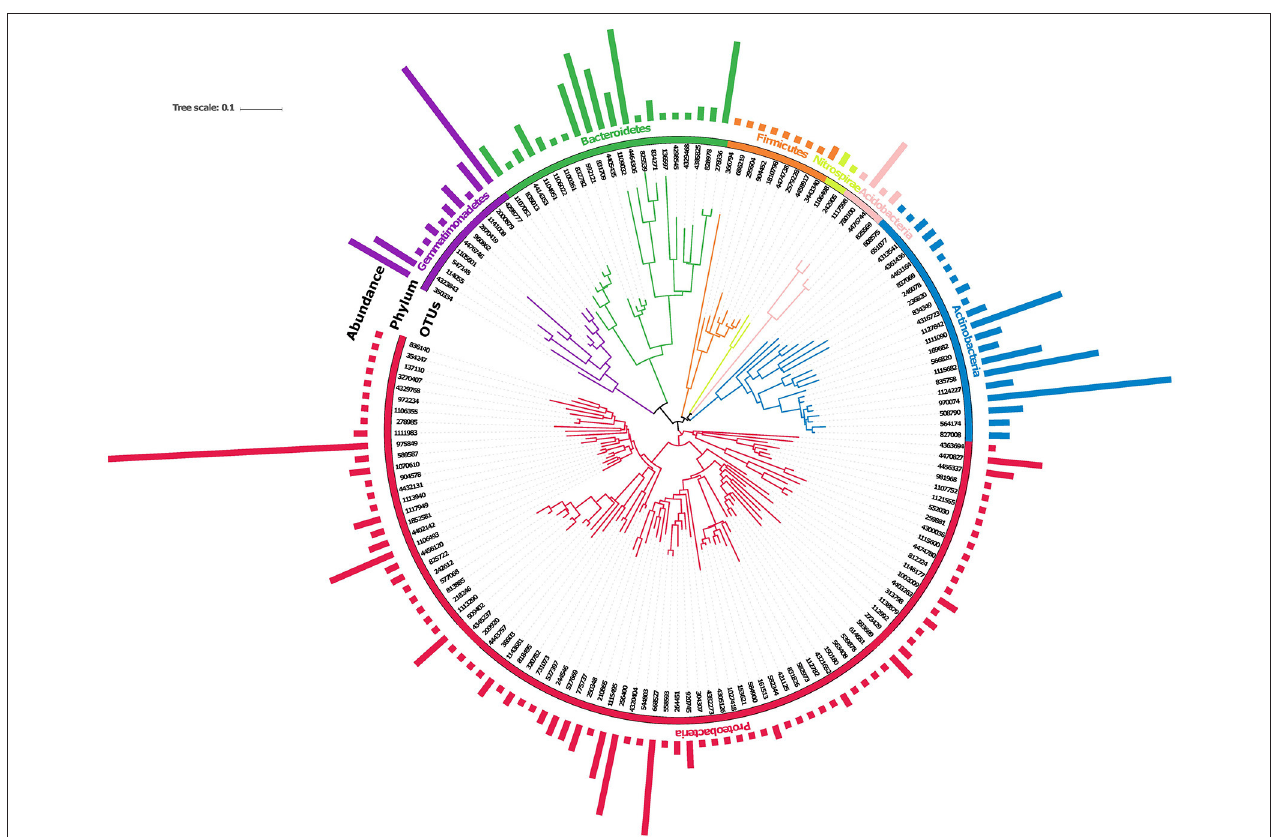
FIGURE 1 | Cladogram of operational taxonomic units (OTUs) identified by SSU rRNA gene sequence